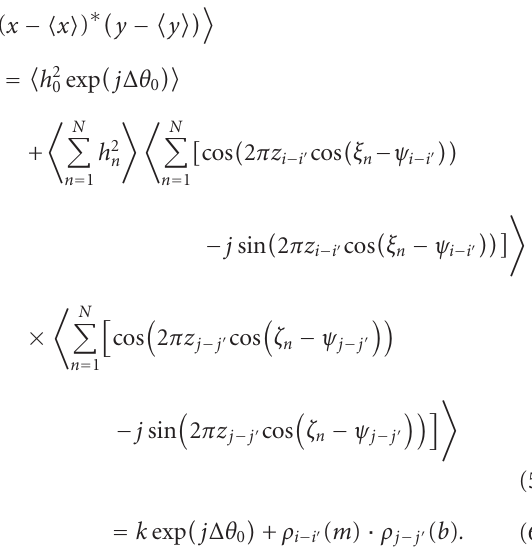
ch ( i − j ), and the complex received signal level E given